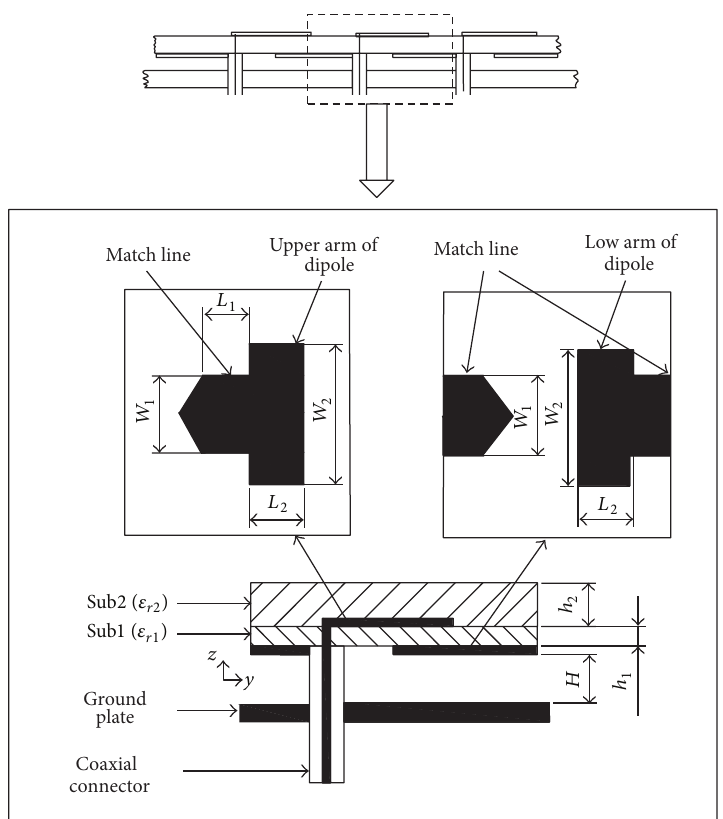
Figure 1: Structure of the center antenna element in infinite array.